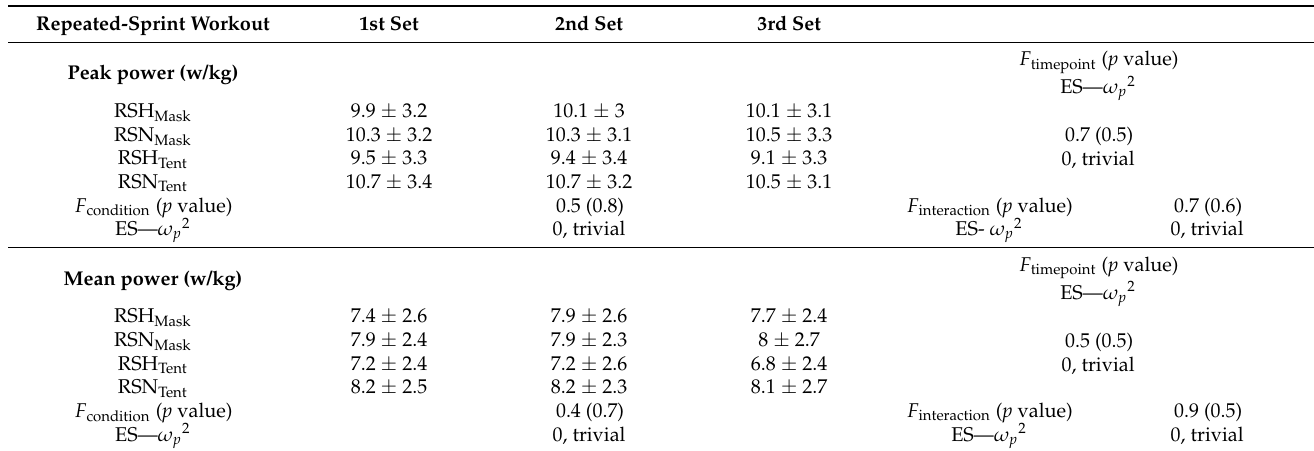
Table 3. Differences in power output by condition during RSA.